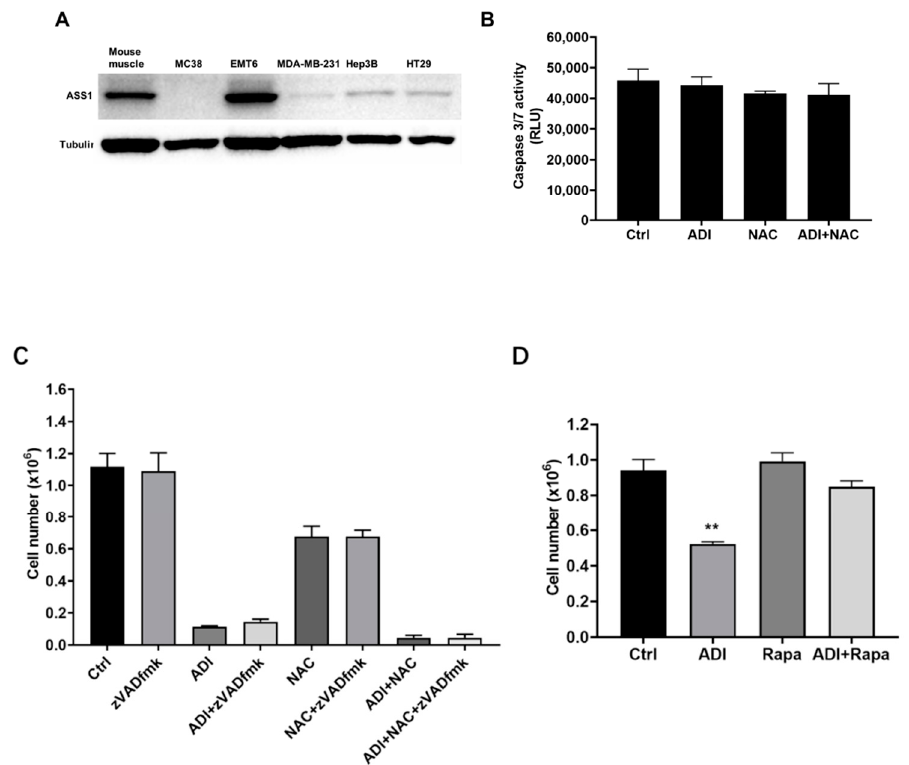
Figure 2. Effect of rapamycin and z-VAD-fmk on ADI-PEG 20-induced cell death in MC38 cells. ( A ) MC38, EMT6, MDA-MB-231, Hep3B, and HT29 cells were examined for ASS1 protein expression by Western blot analysis. Mouse muscle sample was served as ASS1-positive. ( B ) Caspase 3/7 activity of MC38 cells after 24 h of treatment. ( C ) MC38 cells were treated with ADI-PEG 20 (0.2 µ g/mL) and NAC with or without z-VAD-fmk (50 µ M) for 48 h. ( D ) MC38 cells were treated with ADI-PEG 20 (0.025 µ g/mL), with or without rapamycin (400 nM) for 48 h, and cell viability was then determined by trypan blue exclusion assay. The data are presented as the mean ± SD from 3 independent experiments. ** p < 0.01 (comparison to the control).